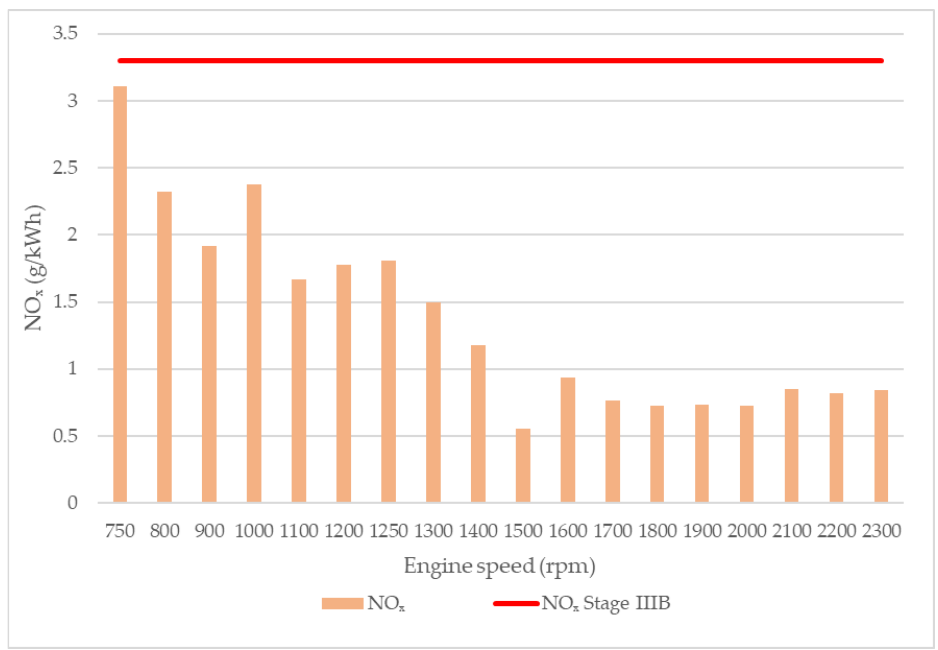
Figure 8. Comparison of NO x depending on engine speed with EPA/COM IIIB standard. During winch operation with a loaded engine, NO x amounts mostly exceed the limit values of the standard. Even when a pulling force of only half the rated power of the winch was applied, the values of the NO x amounts exceeded the limit values. The highest values